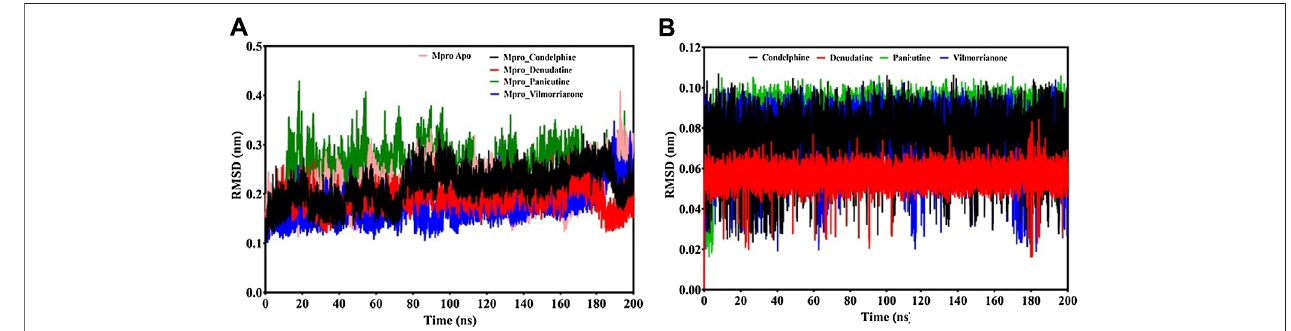
FIGURE 4 | RMSD analysis: (A) backbone RMSD plot of docking complexes and (B) ligand RMSD plot of docking complexes [control (pink), M pro – condelphine (black), M pro – denudatine (red), M pro – panicutine (green), and M pro – vilmorrianone (blue)].